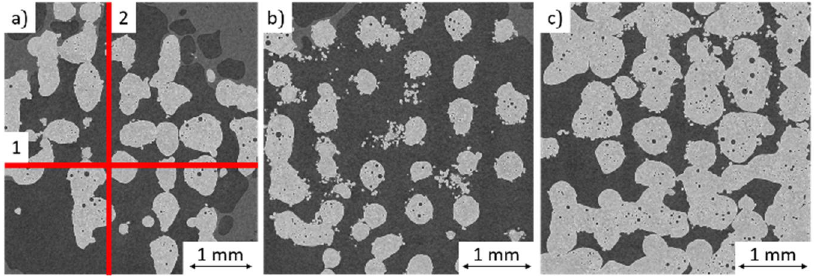
Figure 9. CT Image: ( a ) top view, ( b ) plane 1 sectional side view, ( c ) plane 2 sectional side view of a spherical structure (P L = 300 W, v s = 300 mm/s, g w = 0.3 mm, l s = 350 µm).